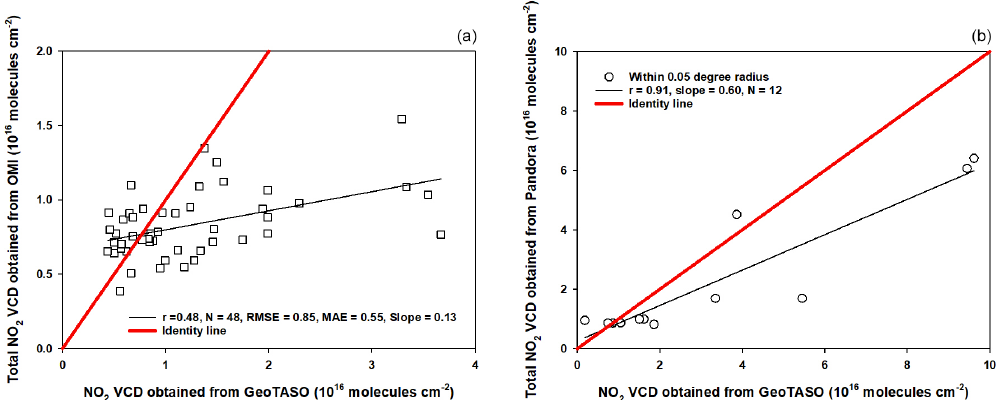
Figure 10. Scatter plots of (a) NO 2 VCD retrieved from GeoTASO and total NO 2 VCD obtained from OMI and (b) total NO 2 VCD obtained from Pandora and NO 2 VCD retrieved from GeoTASO, respectively.